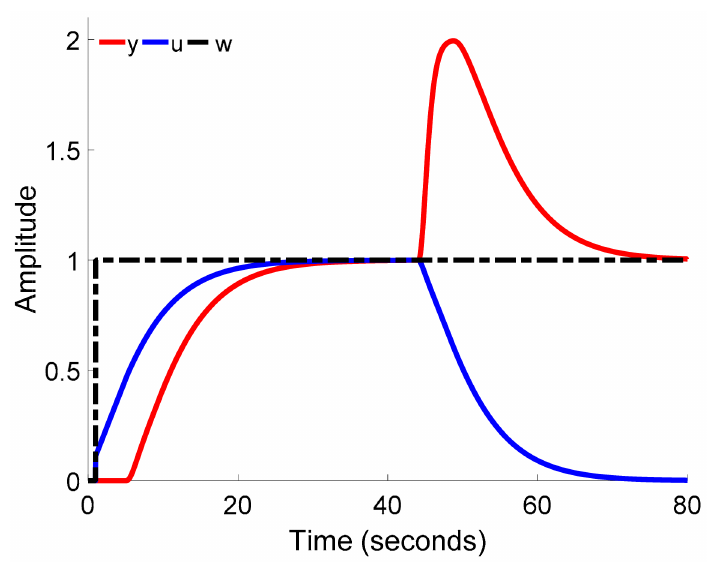
Figure 26. PID control of process